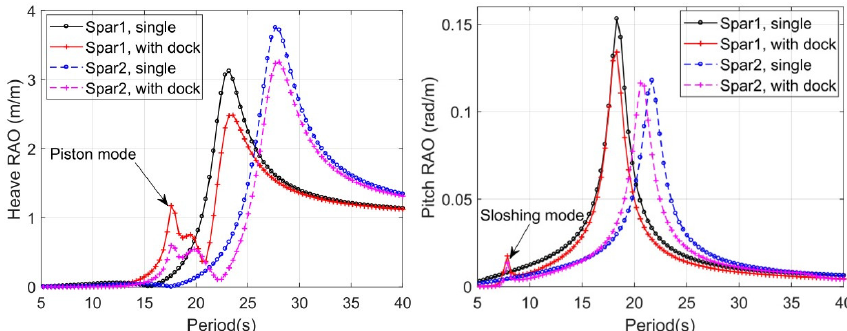
Figure 12. Comparison of the spar RAOs with and without the floating dock (Jiang et al., 2020).